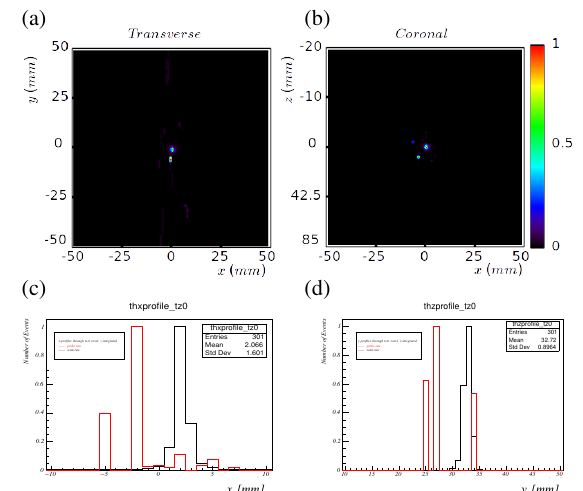
Fig. 8: Two reconstructed images for the 22 Na point-like source. The upper point corresponds to the cases scanner- scanner and scanner-probe and the lower point to the case scanner-probe . Transverse and sagittal planes are shown in (a) and (b), respectively. Profiles of the reconstructed data through the x-axis and y-axis are shown in (c) and (d),